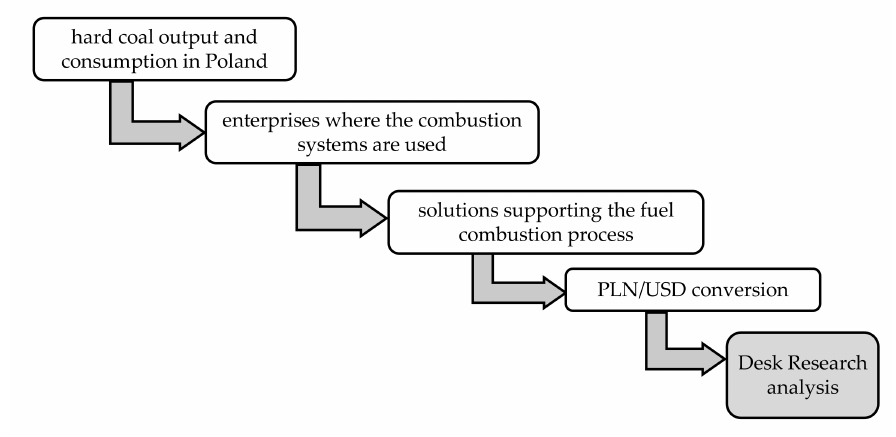
Figure 3. Stepwise acquisition of data for a Desk Research